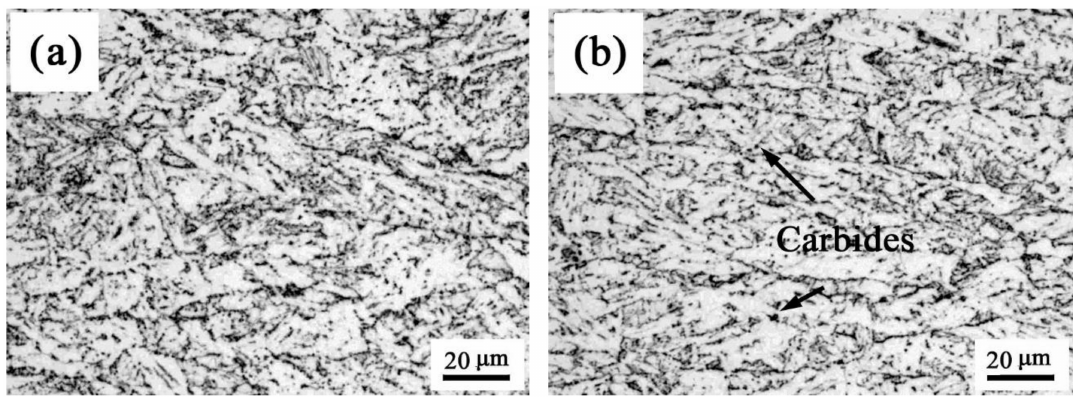
Figure 11. The microstructues of sample #3 cooled by t 8/5 ( a ) 30 s and ( b ) 60 s,